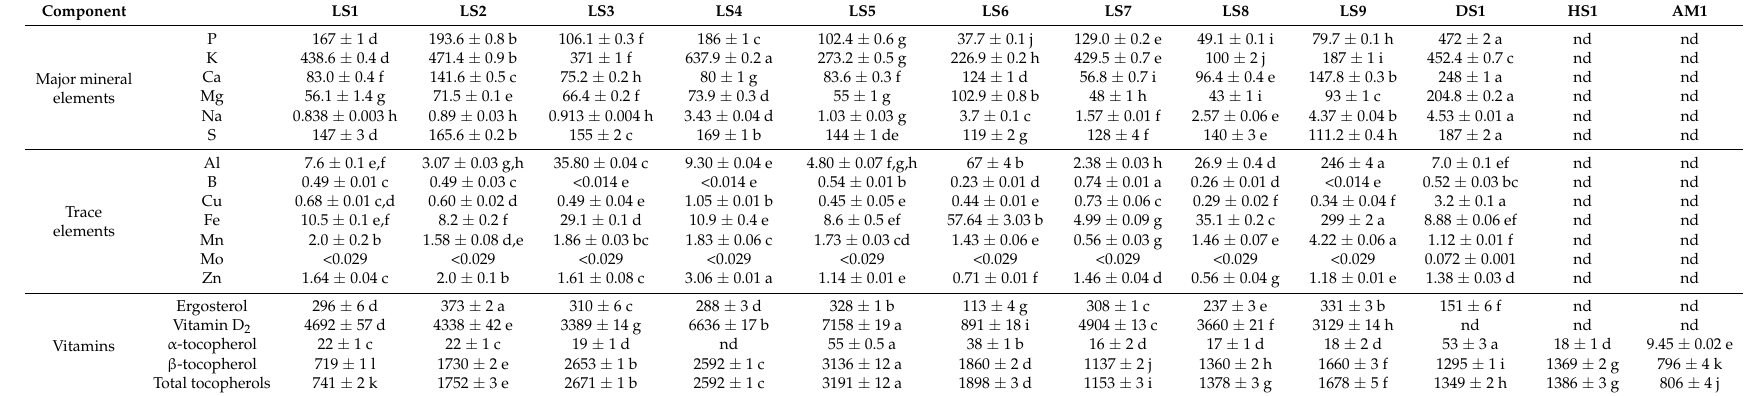
Table 4. Mineral Composition (major & trace) (mg/100 g · dw), ergosterol (mg/100 g · dw), vitamin D 2 (IU/100 g · dw) and tocopherol ( µ g/100 g · dw) contents of studied edible